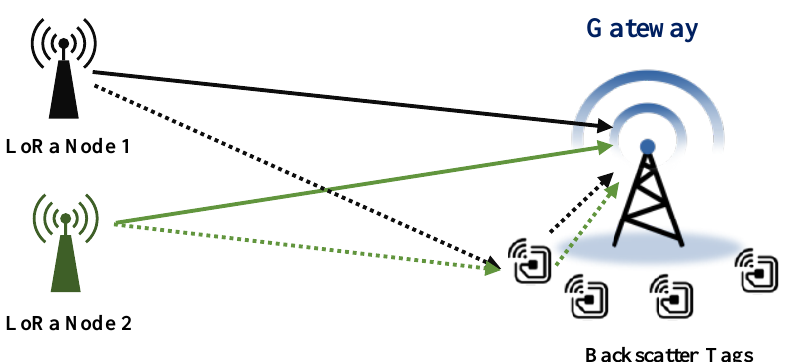
Figure 1. BackLoRa deployment. Battery-free backscatter tags are attached to the gateway to create multipath profile for LoRa